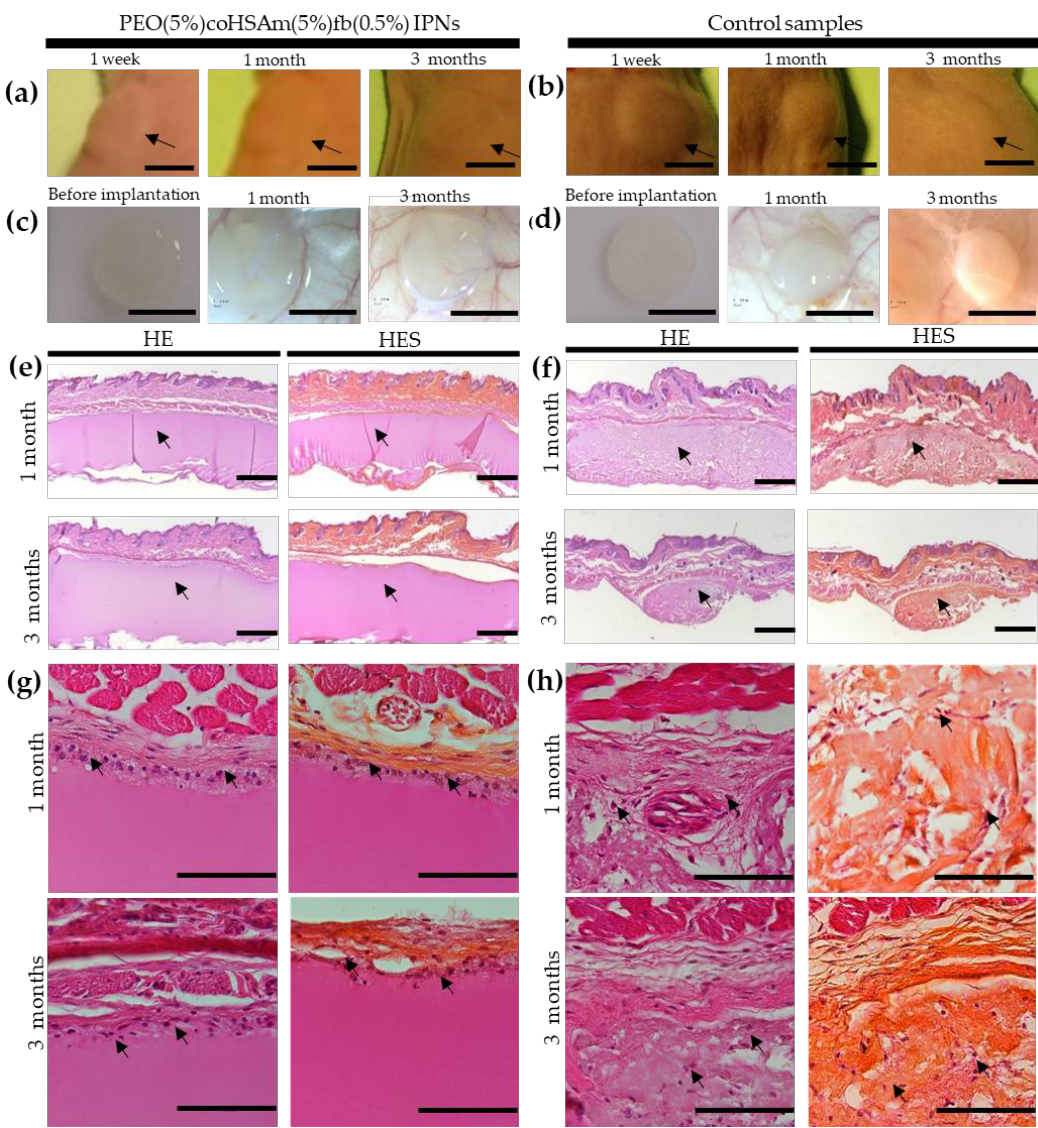
Figure 9. Macroscopic and histologic analyses of PEO(5%)coHSAm(5%)fb(0.5%) IPNs and control collagen-based materials after subcutaneous implantations on nude mice. Nude mice grafted with PEO(5%)coHSAm(5%)fb(0.5%) IPNs ( a ) and control collagen matrices ( b ) after 1 week, 4 weeks and 12 weeks of implantation. Scale bar = 5 mm. Macroscopic images of PEO(5%)coHSAm(5%)fb(0.5%) IPNs ( c ) and control collagen samples ( d ) before implantation, after four weeks and 12 weeks of implantation. Scale bar = 5 mm. Histologic analysis pictures of PEO(5%)coHSAm(5%)fb(0.5%) IPNs ( e , g ) and control ( f , h ) after one month and three months of experiments with hematoxylin eosin staining (HE) and hematoxylin eosin saffron staining (HES). Black arrows depict IPN hydrogels ( e ) and the control collagen samples ( f ), cells on IPN gels within a fibrous capsule ( g ) and cells within collagen scaffolds ( h ). ( e , f ) Macroscope images with magnification ×1.6. Scale bar = 500 μm. ( g , h ) Microscope images with magnification ×40. Scale bar = 100 μm.